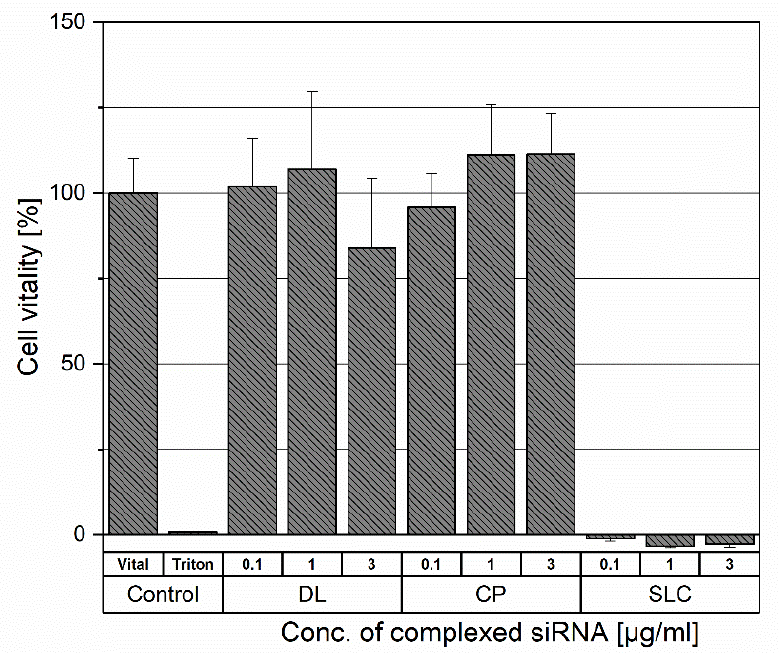
Figure 2. Cytotoxicity of DL, CP, and SLC 96 h after transfection at concentrations of 0.1, 1 and 3 µg/mL of complexed siRNA. The control group consists of the untreated cells for the 100% vitality value and the Triton X100 treated group for the maximum cytotoxic value.